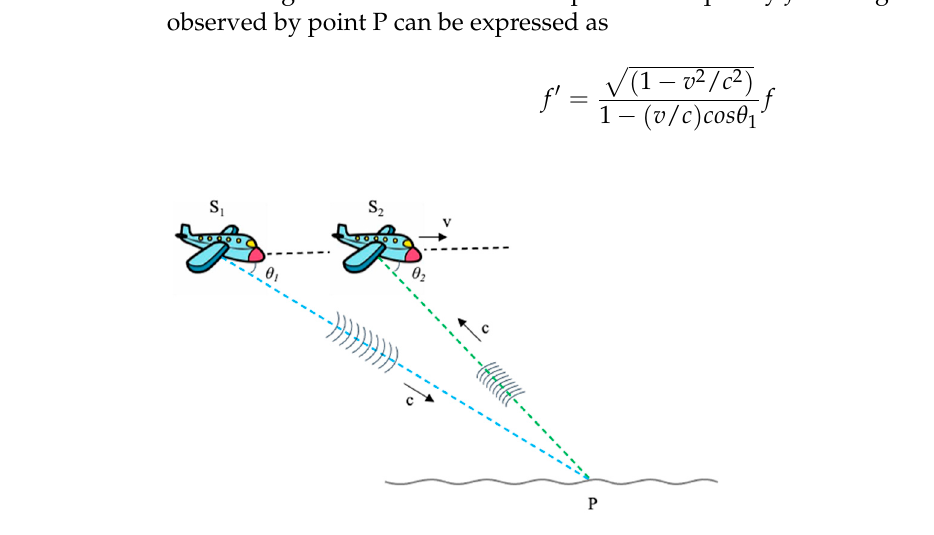
Figure 2. Illustrations of the principle of the Doppler shift during the flight campaign. For the flight campaign, the IPAD lidar onboard Yunshuji-8 (Yun- 8) transmits two laser pulses and collects the echo signal scattered by the ground or cloud. Two successive Doppler effects are involved in the process of wave propagation, as shown in Figure 2. First, the moving source transmits a laser pulse of frequency to the ground P. The fre-